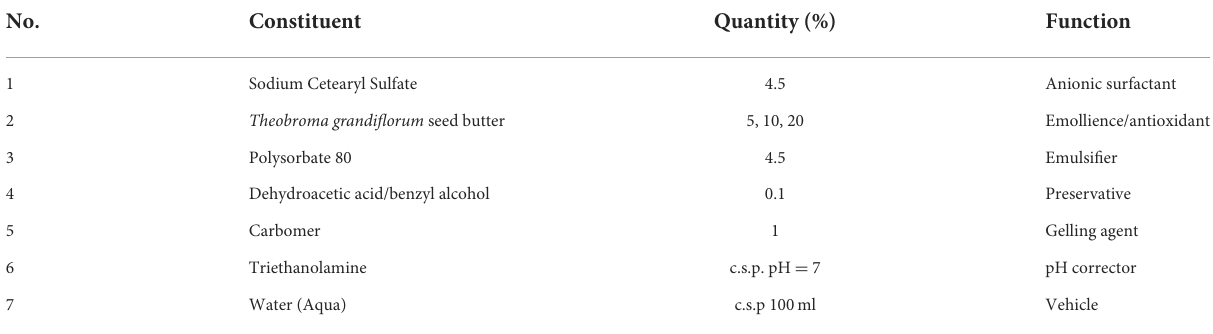
TABLE 1 Formulation of emulgels containing Copoazú seed butter at 5, 10, and 20%.